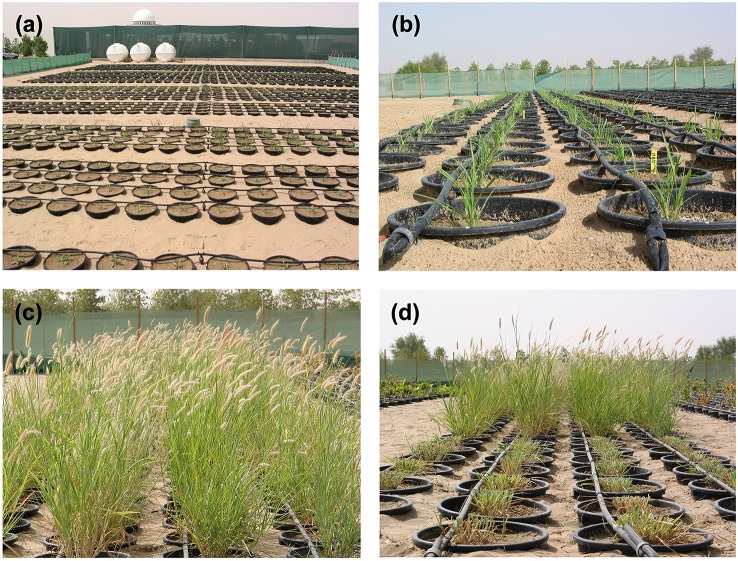
Screening Cenchrus ciliaris for salt tolerance in pots buried in open field at Research Station, ICBA, Dubai, UAE. (A) Germination, (B) growth and tillering, (C) heading stage, and (D) harvesting.